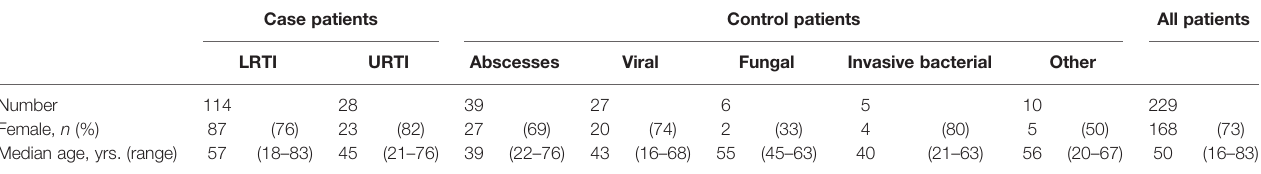
TABLE 1 | Patients categorized by their dominating type of